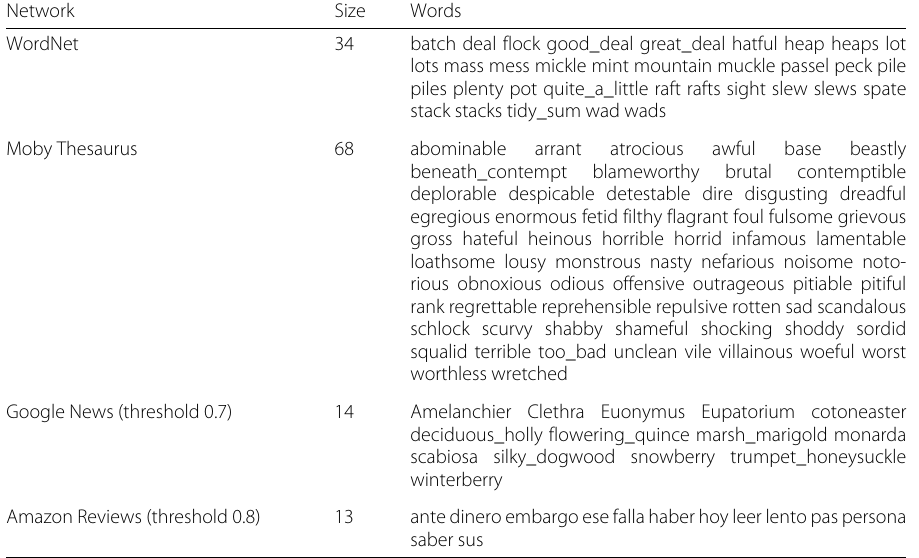
Table 2 Largest cliques in WordNet and Moby Thesaurus networks, as well as in word2vec Google News and Amazon Reviews networks containing words from WordNet